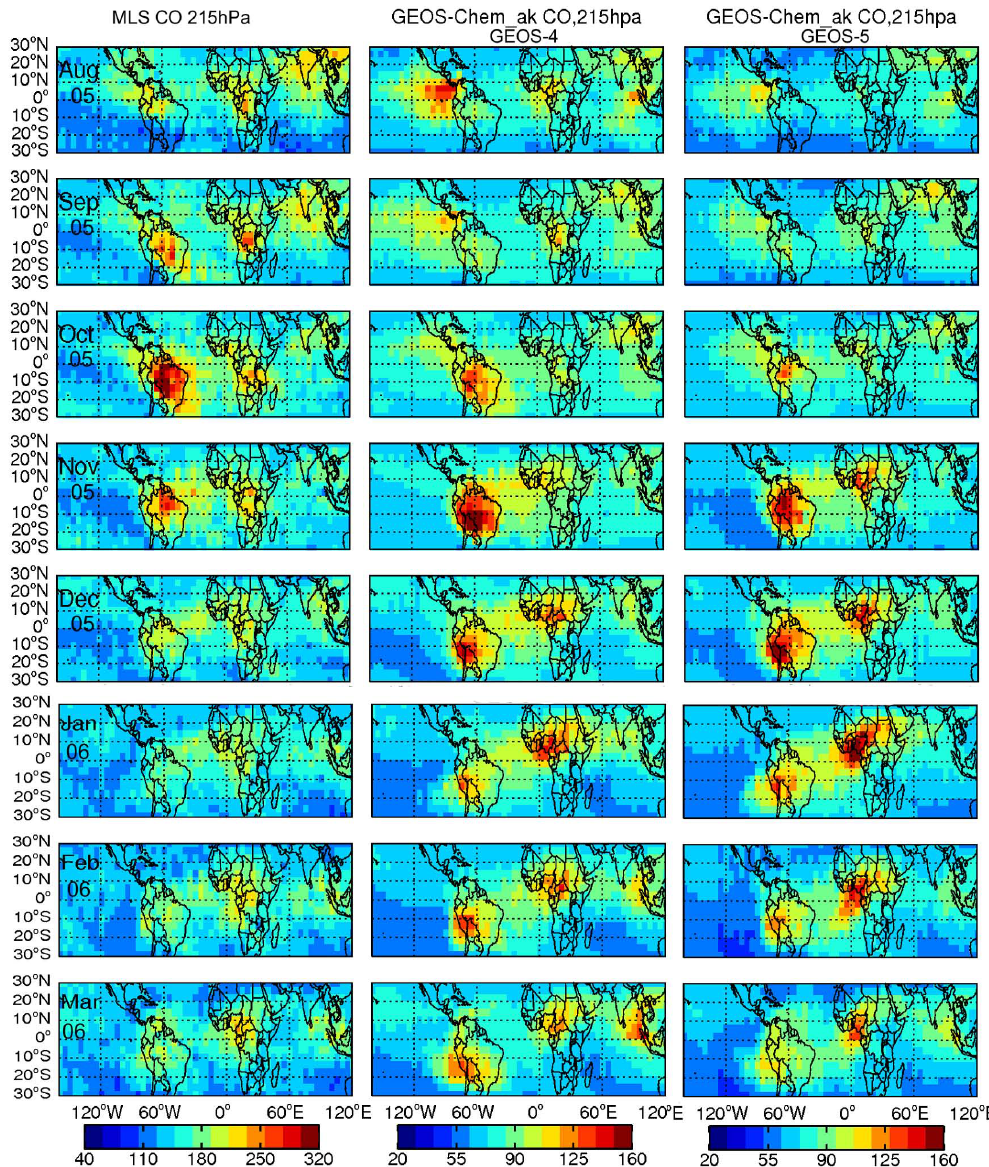
Fig. 5. Upper tropospheric CO at 215hPa from August 2005 to March 2006 from MLS (left), the simulations driven by GEOS-4 (middle) and GEOS-5 (right) with the MLS AKs applied. The color bar range of MLS is twice of that of model results because of the factor of two high bias of the MLS retrieval at 215hPa (Livesey et al. 2008). Difference plots are not shown because of concern over the absolute accuracy of the CO